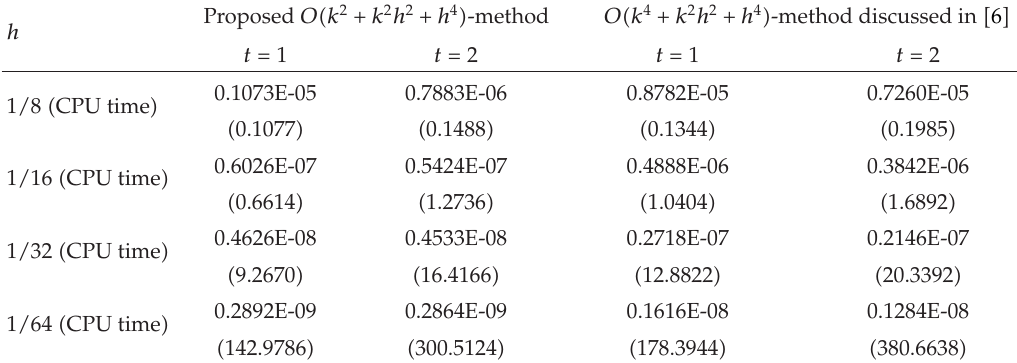
Table 2: Example 6.2: the maximum absolute errors (cid:4) with CPU time (cid:5) .